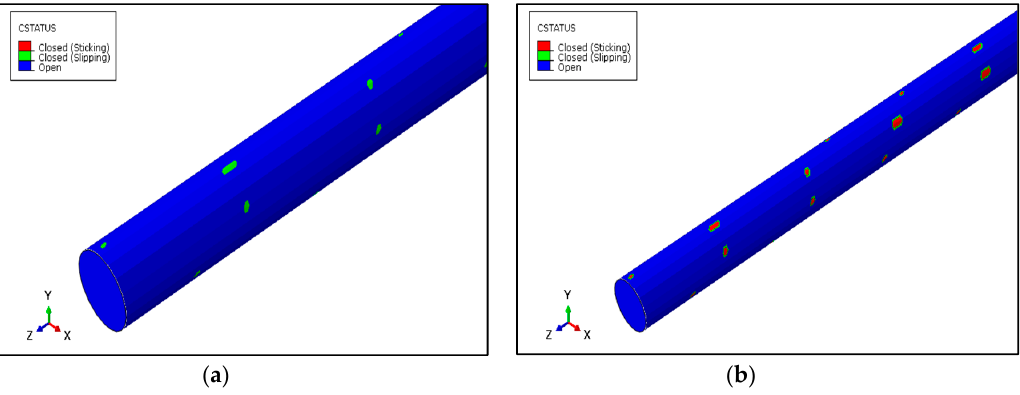
Figure 6. ( a ) Spots on Core Wire showing slipping with neighboring wires when there is no friction. ( b ) Spots on Core Wire showing sticking and slipping with neighboring wires when friction is present.